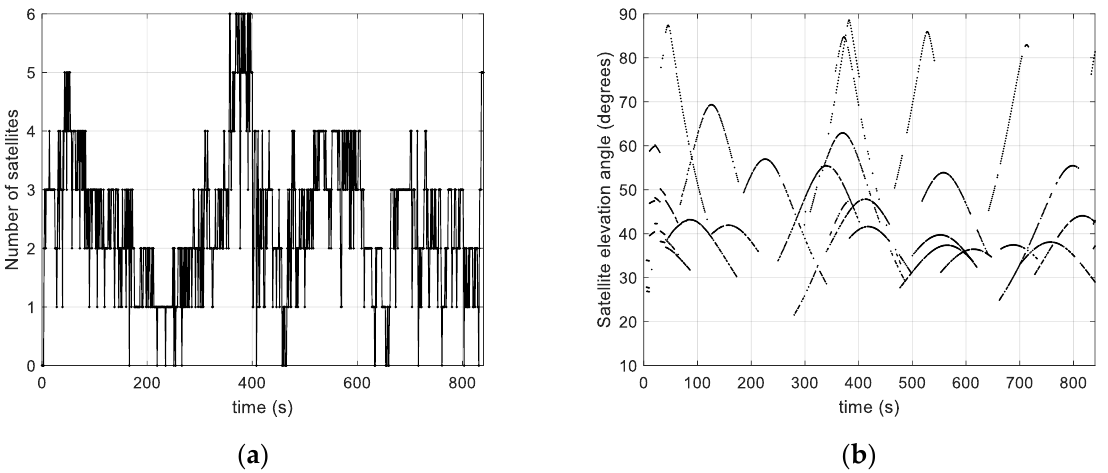
Figure 12. ( a ) Number of tracked satellites as function of time; ( b ) satellites’ elevation angles at measurement epochs.